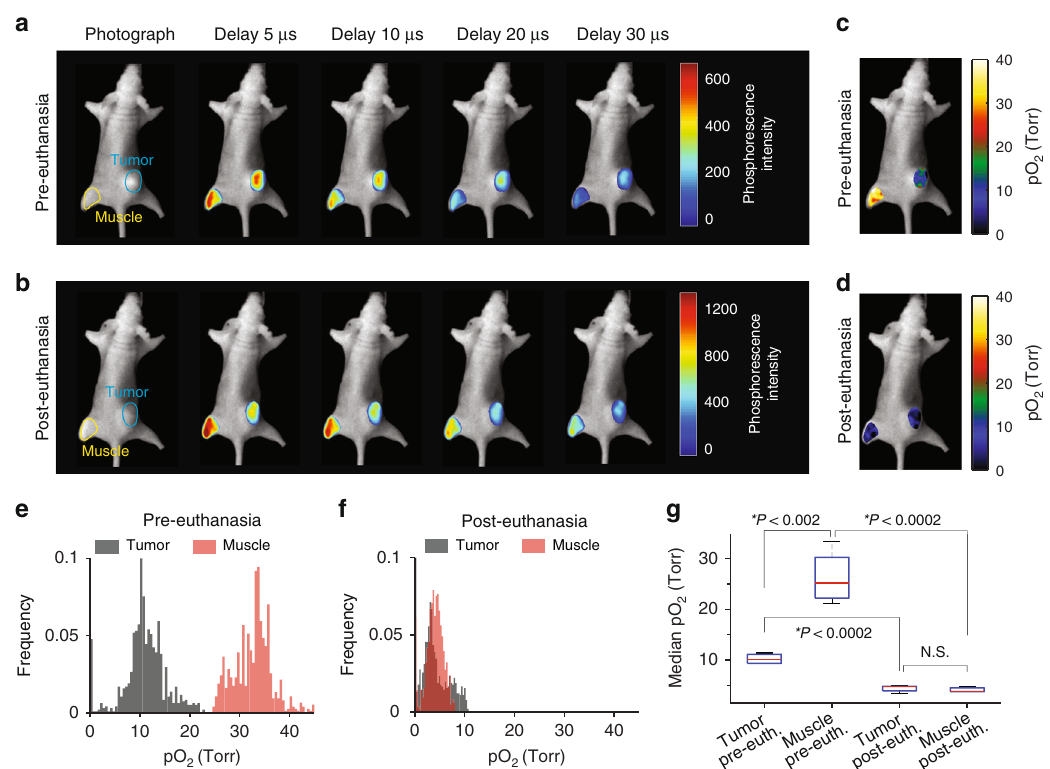
Fig. 3 CELI of oxygen in tumors and muscle in vivo before and 30 min after euthanasia. Oxyphor PtG4 (50 μ L of 200 μ M solution) was locally injected into the MDA-MB-231 tumor (blue circle) and into muscle (yellow circle) before the imaging session. a , b Phosphorescence intensity images acquired at different delays relative to the radiation pulse before ( a ) and after euthanasia ( b ). The phosphorescence images are overlaid on a photograph of the mouse, which was taken before CELI. The tumor and muscle areas used for the analysis are encircled. Tissue oxygen maps ( c , d ) and pO 2 histograms ( e , f ) before and after euthanasia. g Average levels of oxygen in the tumor and muscle before and after euthanasia ( n = 4). Boxplot shows median and interquartile range; whiskers indicate the range. Statistics was performed using two-sample t